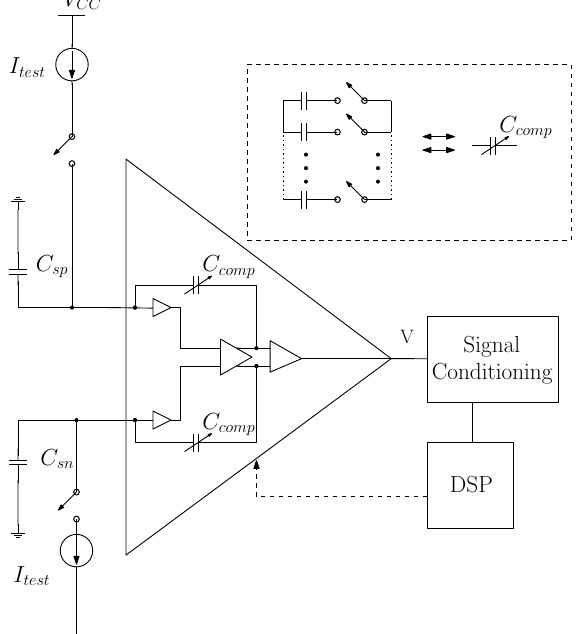
Figure 4. Internal compensation to the instrumentation amplifier. C sp + , C sp − are the parasitic capacitances observed in the instrumentation amplifier’s input nodes. I test is the current source used to calibrate the compensation system, C comp